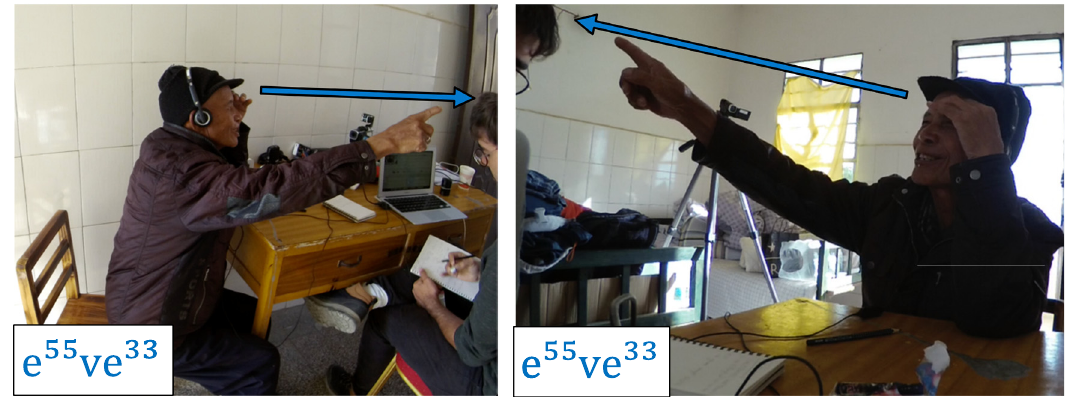
Figure 4: BLW points at his addressee ’ s hair. Co - timed with speaker deictic in Example 7 – same frame, di ff erent